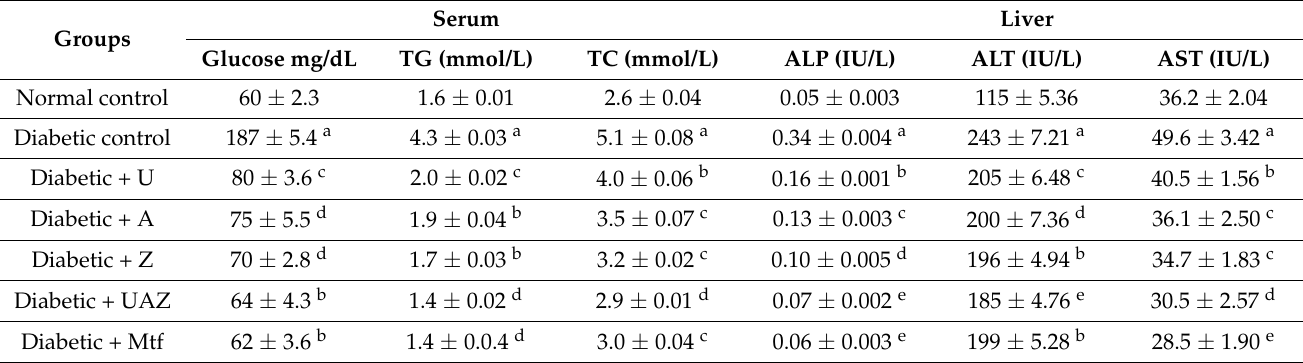
Table 6. Effect of U, A, and Z, and UZA on glucose in serum and liver enzymes in glucose-induced diabetic zebrafish.